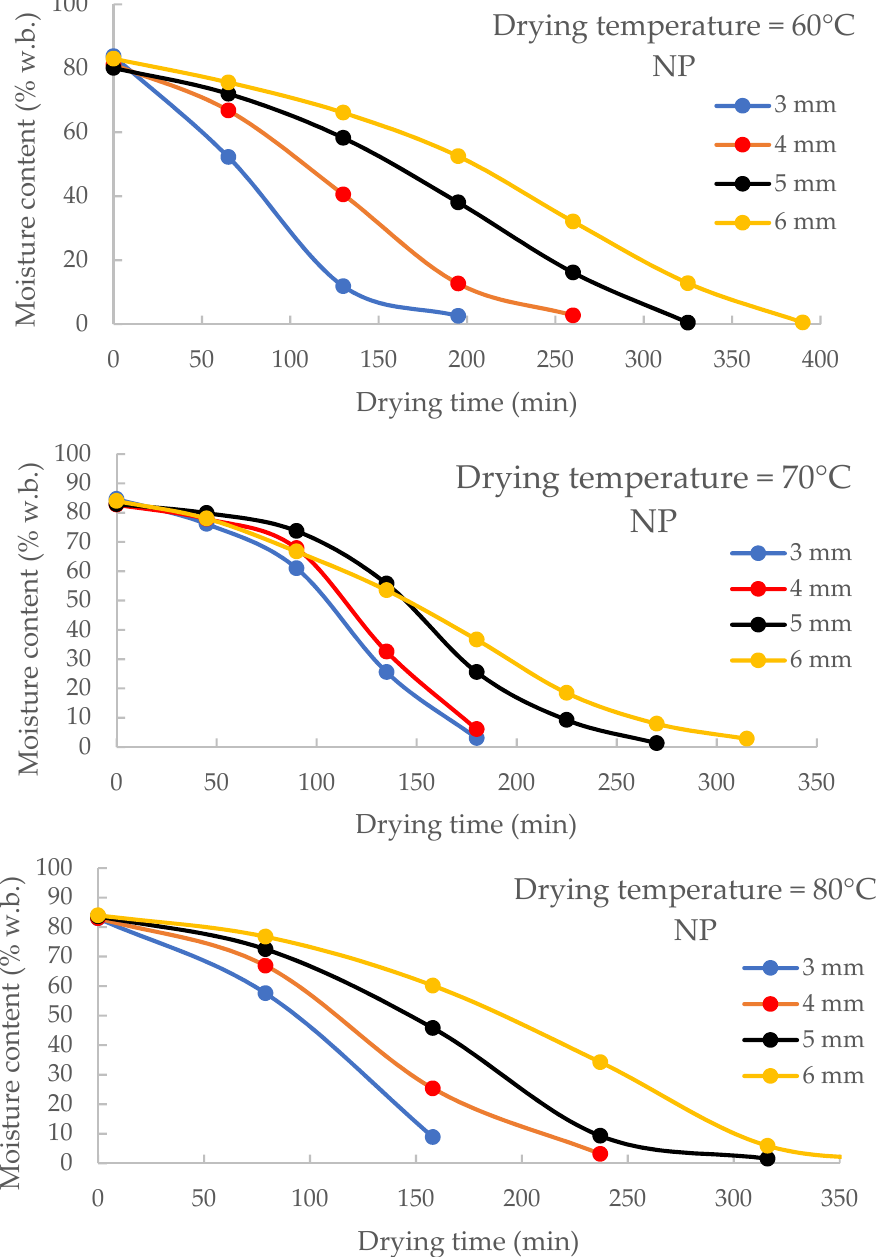
Figure 2. Effect of slice thickness on drying time of non-pre-treated (NP) quince fruit at different drying air temperatures.